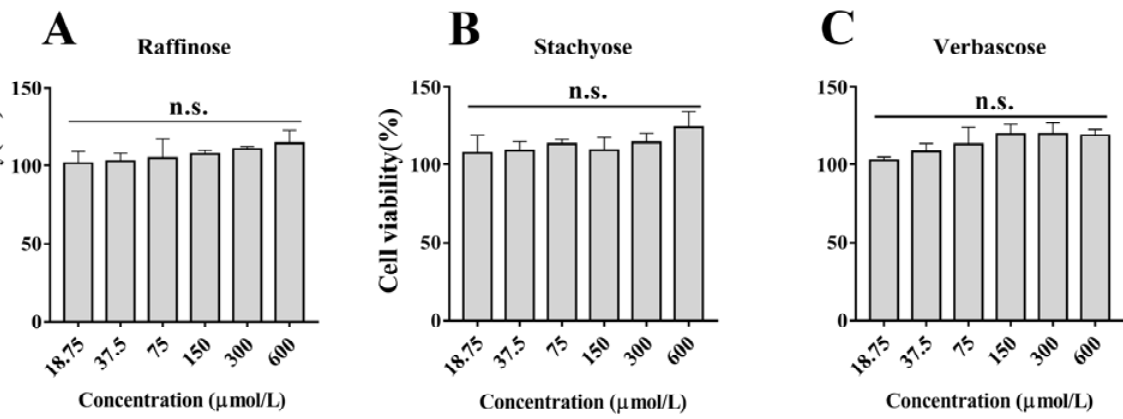
Figure 1. Effects of different concentrations of natural GOS (raffinose, stachyose and verbascose) on cell viability of RAW264.7 macrophages after treatment for 24 h: ( A ) Raffinose, ( B ) Stachyose and ( C ) Verbascose. N.s., not significant (n = 3).